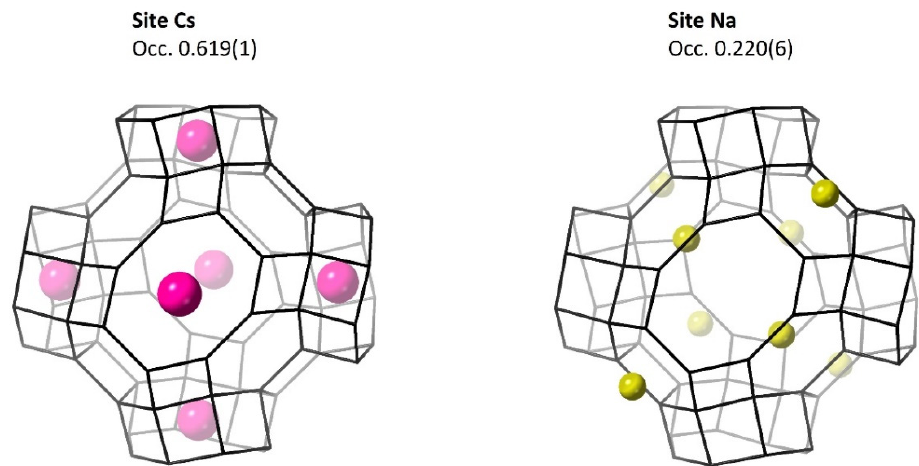
Figure 3. Location of the Cs and Na cation sites determined in the empty zeolite RHO. The framework is shown as a stick model, the caesium cations as pink spheres and the sodium cations in yellow. The fractional occupancy (Occ.) of each site is also included.